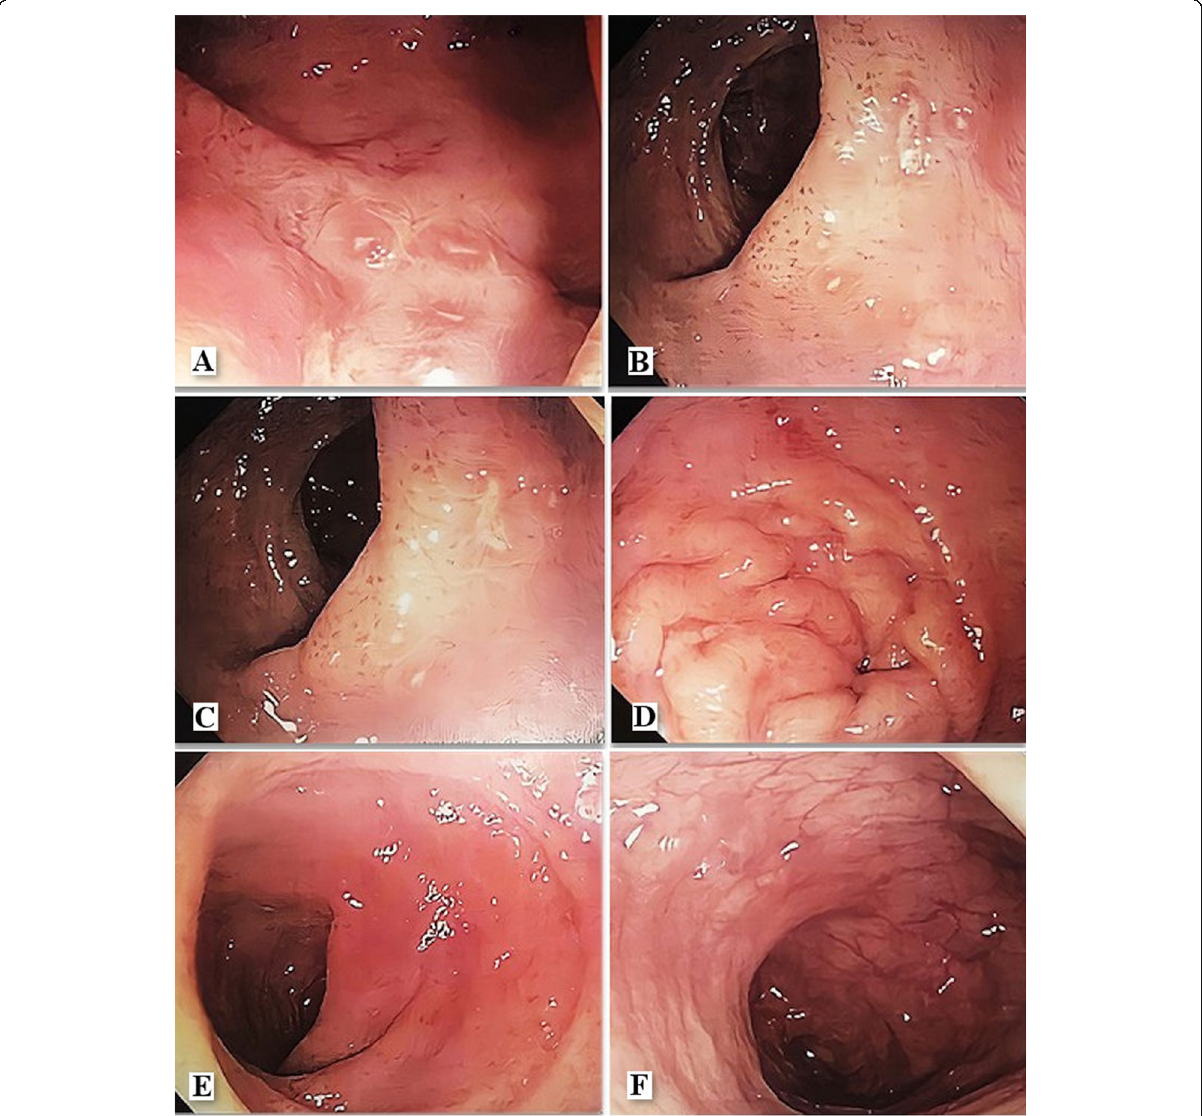
Fig. 1 Colonoscopy. Erosions in rectal mucosa (A,B,C), edema in distal sigmoid (D) mucosal erythema in distal sigmoid (E) and normal sigmoid mucosa